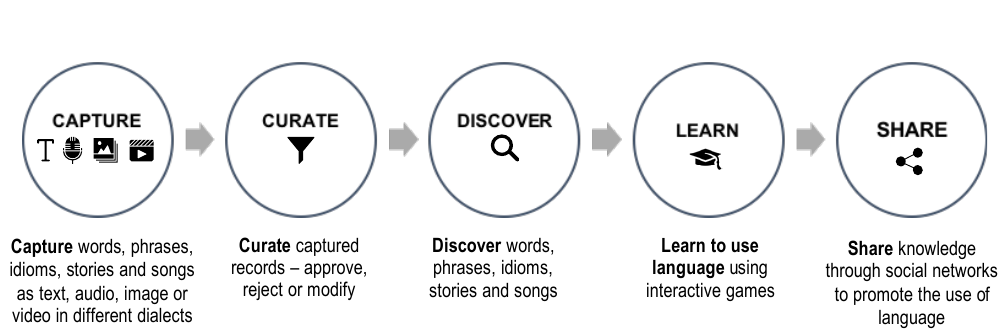
Figure 2. Key concepts and processes to harness collective intelligence to revitalise endangered